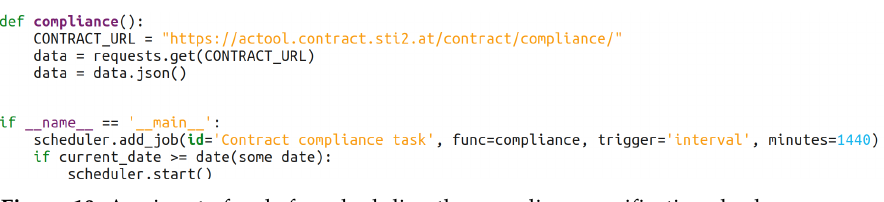
Figure 10. A snippet of code for scheduling the compliance verification